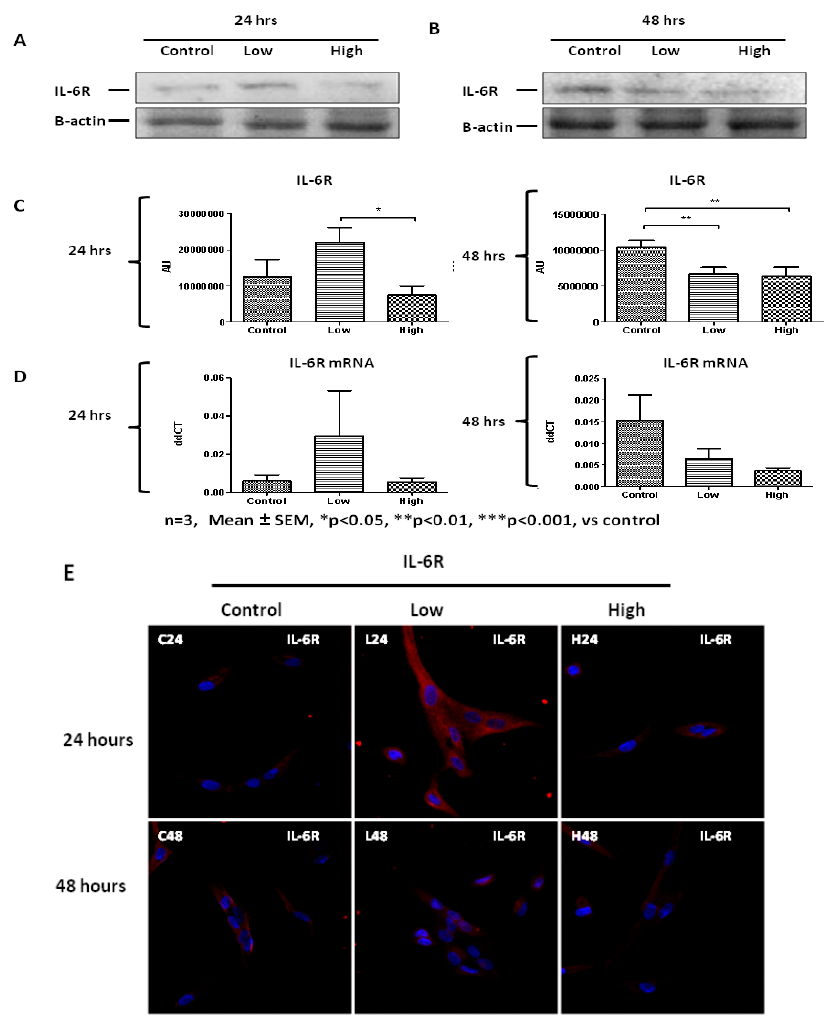
Figure 11. Concentration- and time-dependent effects of low and high IL-6 concentrations on IL-6R expression in PHMs. ( A ) Western blot determination of IL-6R protein levels 24 h after treatment with low and high IL-6 concentrations. ( B ) Western blot determination of IL-6R protein levels 48 h after treatment with low and high IL-6 concentrations. ( C ) Quantification of IL-6R protein levels as shown in ( A ). ( D ) Quantification of IL-6R mRNA levels after treatment of cells with low and high IL-6. ( E ) Real time PCR analysis of IL-6R mRNA transcripts 24 h after treatment of PHMs with low and high IL-6 concentration. ( F ) Real time PCR analysis of IL-6R mRNA transcripts 48 h after treatment of PHMs with low and high IL-6 concentration. ( E ) Immunofluorescence staining for IL-6R after treatment of PHMs with low and high IL-6 concentration for 24 (top panel) and 48 h (lower panel). The experiment was repeated three times. Immunofluorescence images were taken at 100× magnification. Results are presented as mean ± standard error of the mean (S.E.M). Statistical analysis: ANOVA and Bonferroni post hoc test. * p < 0.05; ** p < 0.01.